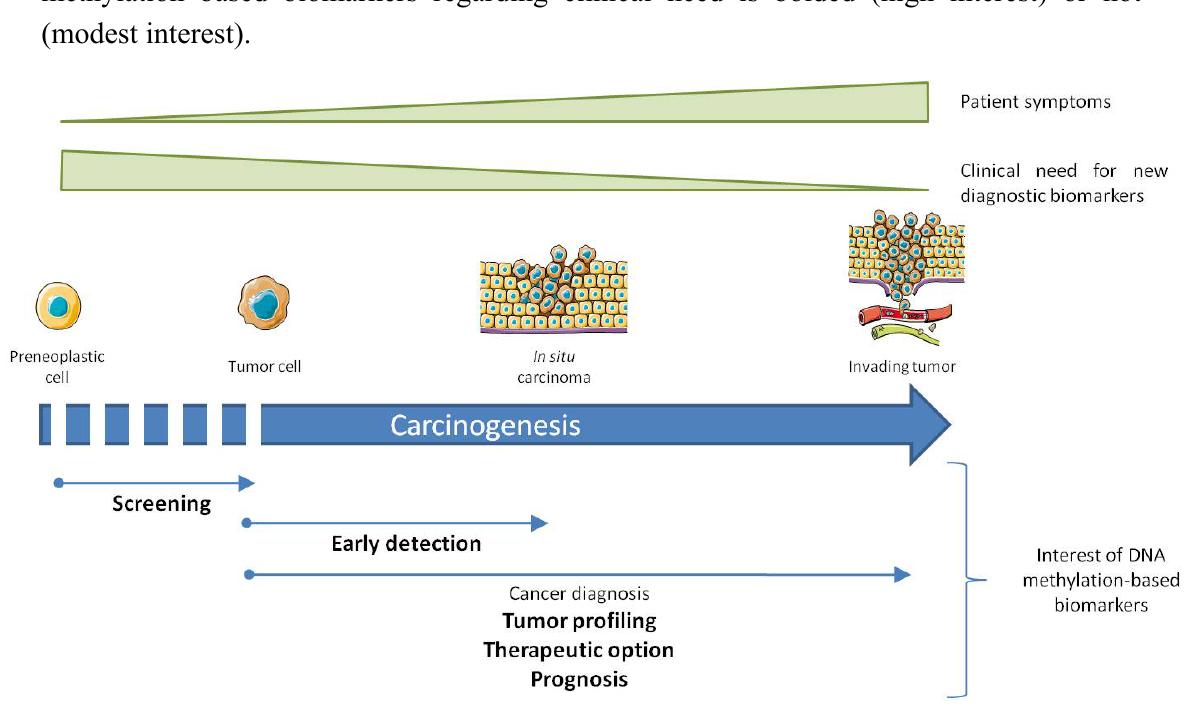
Figure 1. Interest of DNA methylation biomarker in cancer diagnosis. Thin